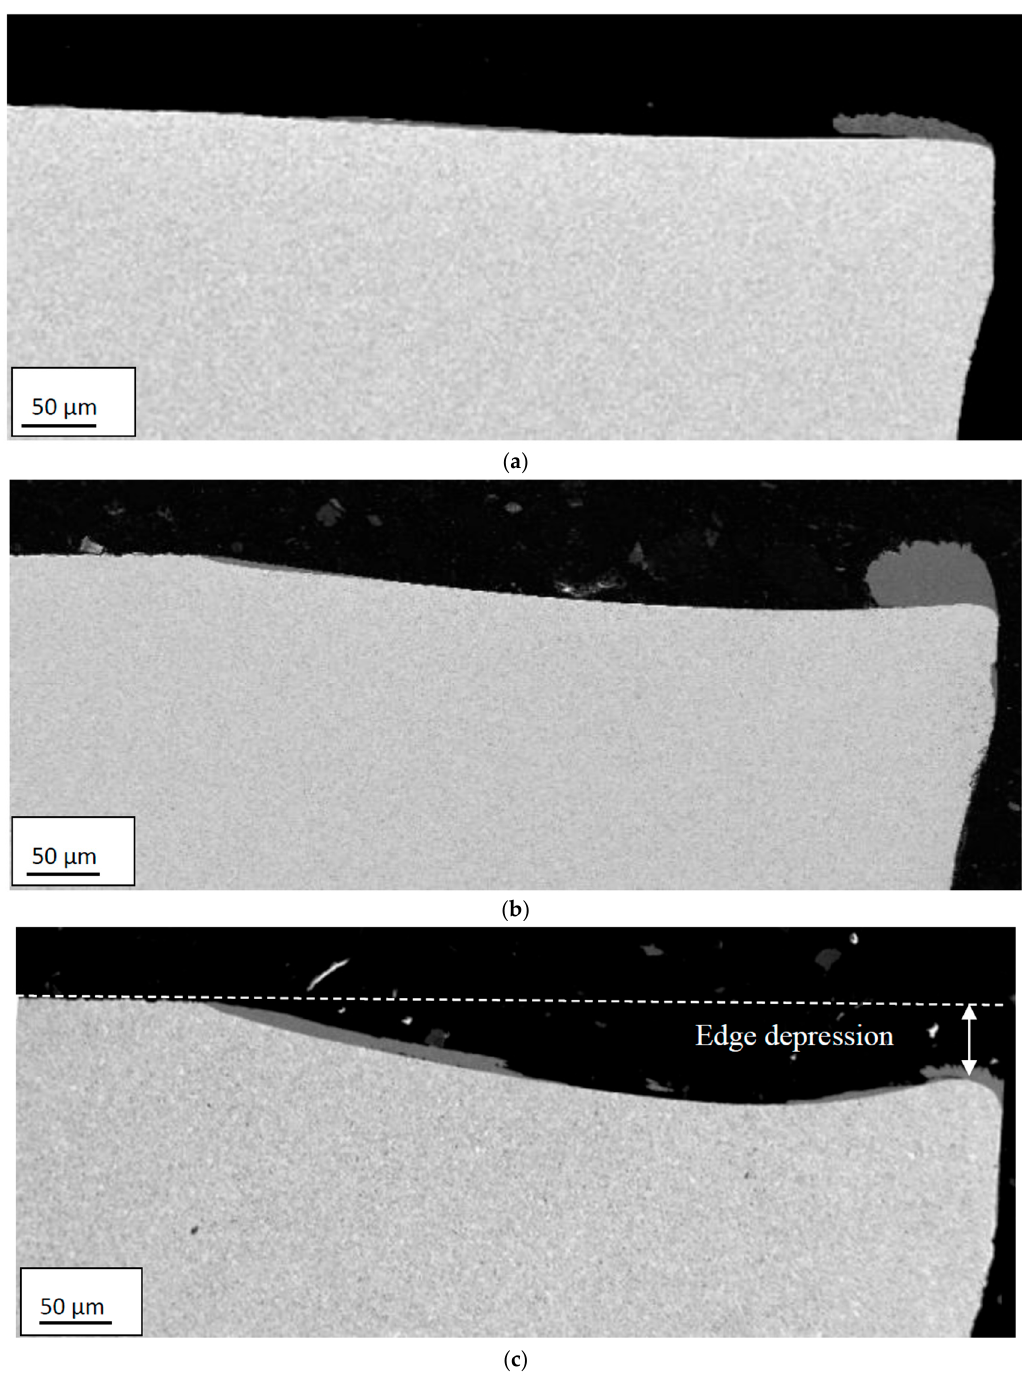
Figure 9. Cross-sections illustrating the influence of time on the resulting crater and flank wear characteristics. ( a ) 1 min; ( b ) 2 min; ( c ) 3 min. Cutting speed: 90 m/min, Feed rate: 0.2 mm/rev. Note the pronounced edge depression observed at the high cutting speed.